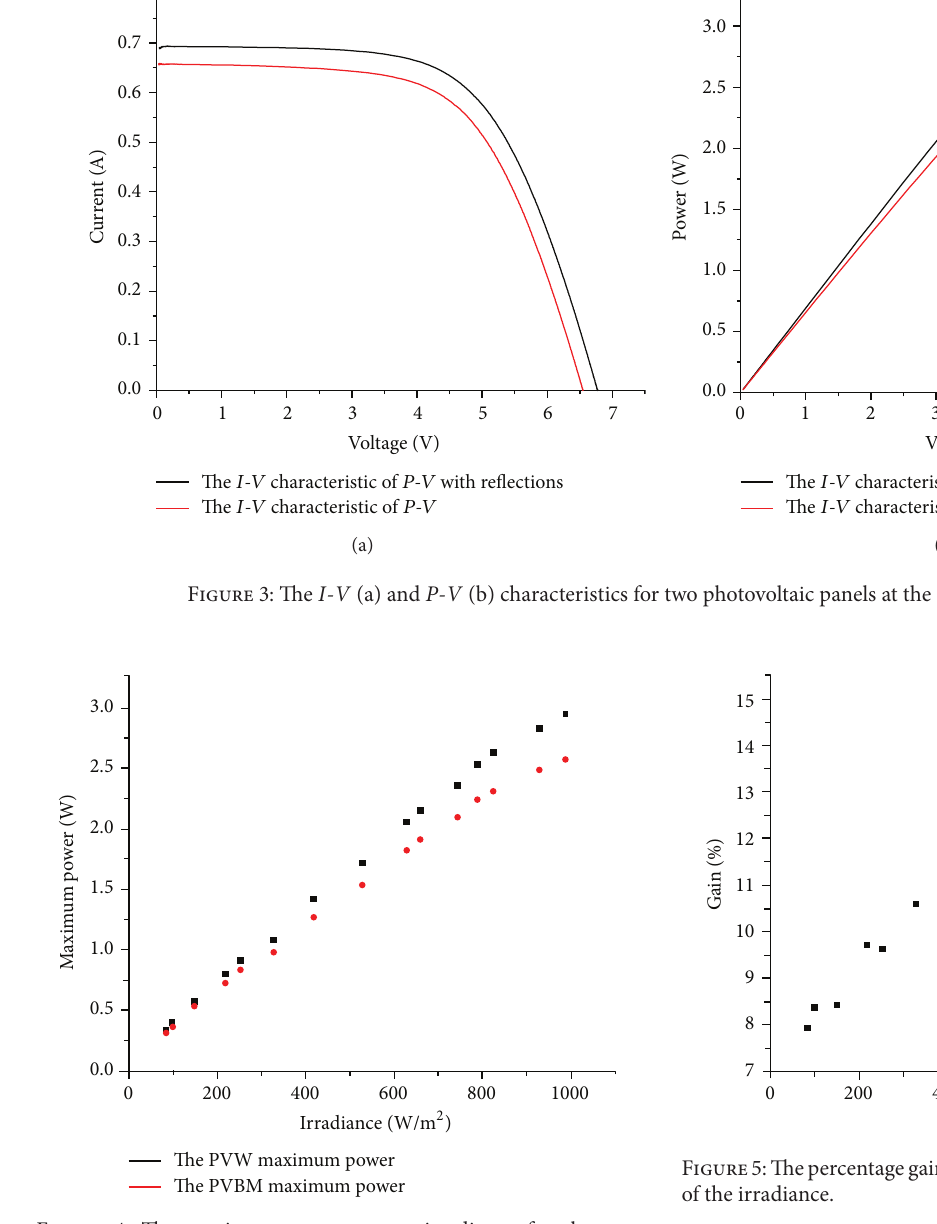
Figure 4: The maximum power versus irradiance for the two photovoltaic panels.